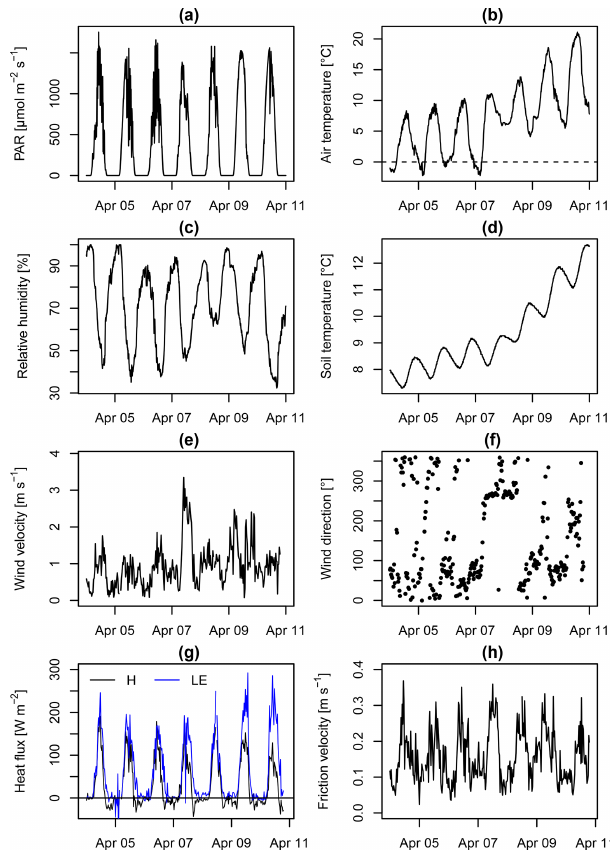
Figure 7. Meteorological conditions and turbulent energy fluxes during the experimental period from 4 to 10 April 2015: photosyn- thetically active radiation (PAR), air temperature, relative humid- ity, soil temperature, wind velocity, wind direction, sensible heat flux ( H ), latent heat flux (LE), and friction velocity. The wind and eddy covariance flux observations shown in panels (e) – (h) were ob- tained from the R3 sonic of the eddy accumulation system in com- bination with the LI-7500 gas